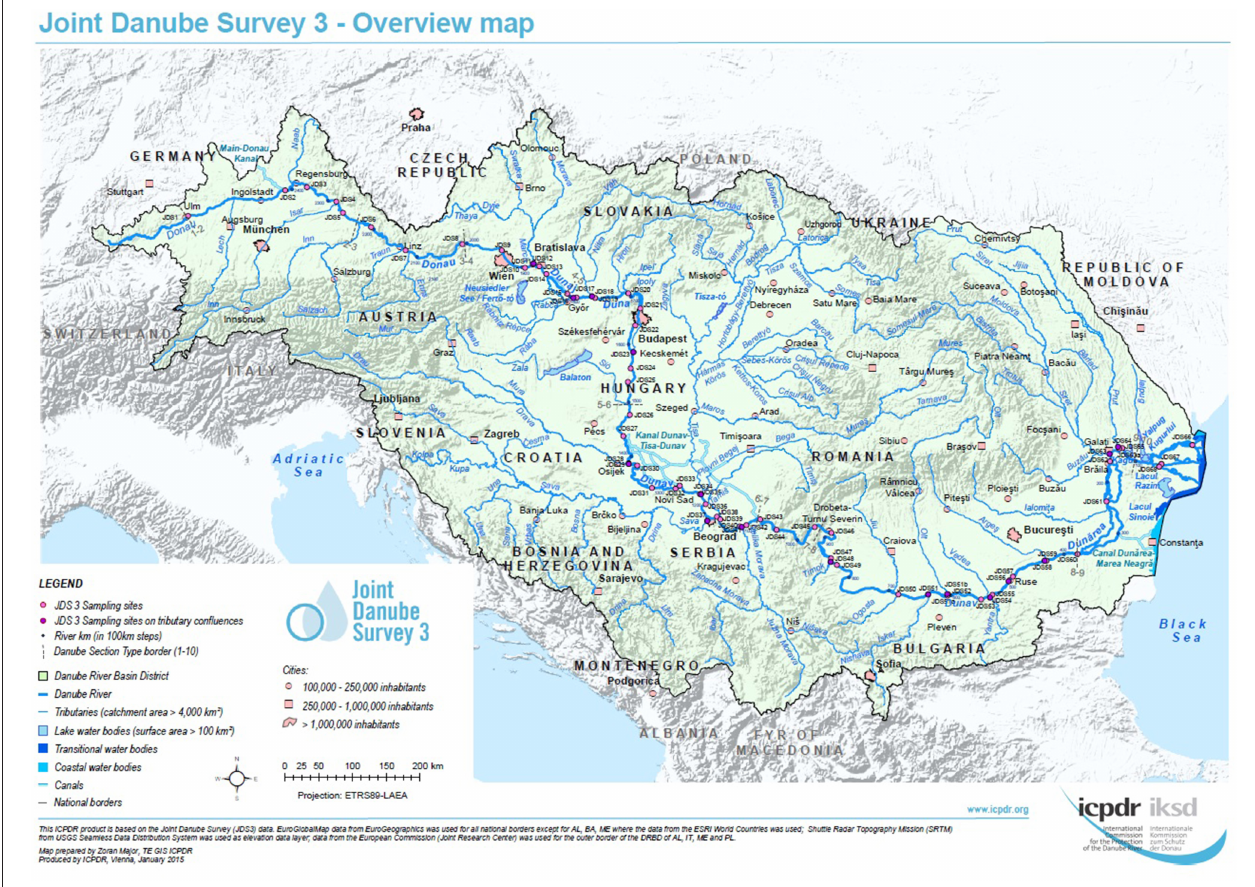
FIGURE 1 | Overview of the JDS3 sampling points along the river Danube. The map was taken with kind permission of the ICPDR. (http://www.danubesurvey.org/results).